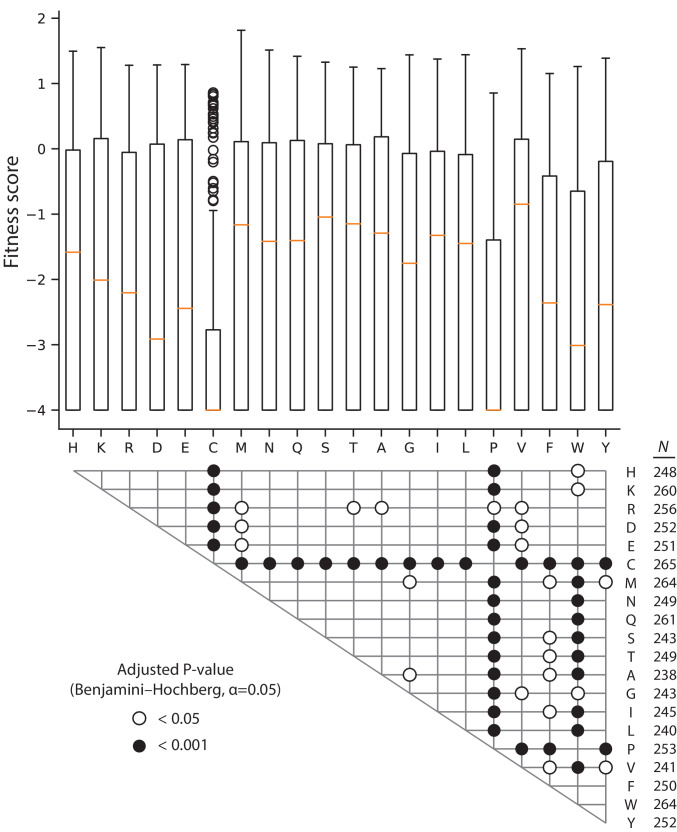
Comparison of fitness score by variant residue in 128 µg/mL AMP.The box and whisker plots depict the distribution of fitness scores for all missense variants mutated to the indicated amino acid, with the median highlighted by the orange line. The grid below the plot shows the significant results of two-tailed Mann-Whitney U tests between all pairwise combinations of amino acid fitness score distributions; the P-values are adjusted for false discovery rate using the Benjamini-Hochberg procedure with α = 0.05 (190 tests total). The number of variants in each amino acid distribution is shown to the right of the grid.